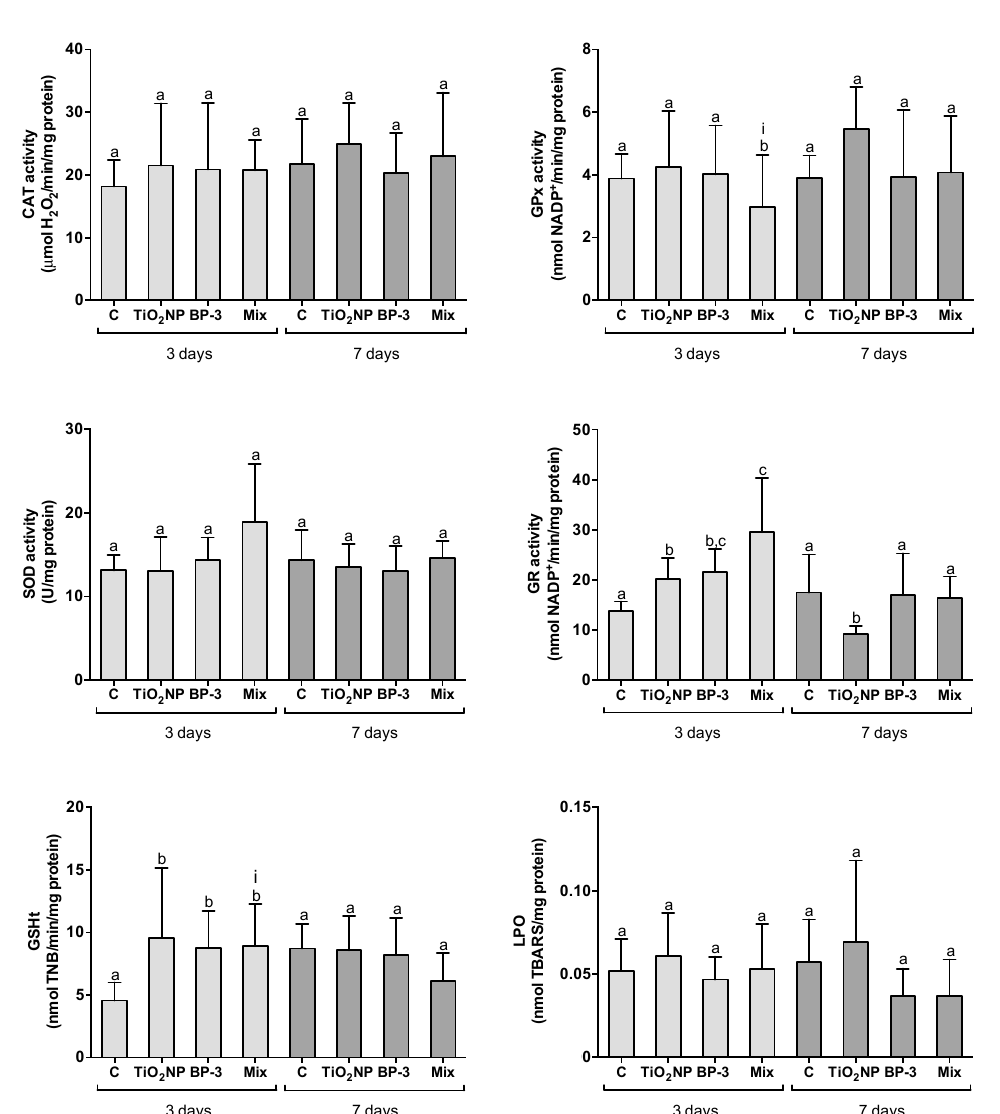
Figure 2. Oxidative stress responses in the intestine of S. maximus , 3 and 7 days after intraperitoneal injection of titanium dioxide nanoparticles (TiO 2 NPs; 3.0 µ g TiO 2 NP per g fish weight), oxybenzone (BP-3; 3.0 µ g BP-3 per g fish weight) or their mixture (Mix), as well as the respective control group (C). Different lower-case letters denote significant differences ( p < 0.05). Significant interaction between TiO 2 NPs and BP-3 is depicted by (i) ( p < 0.05). Columns correspond to mean and error bars represent the standard deviation.